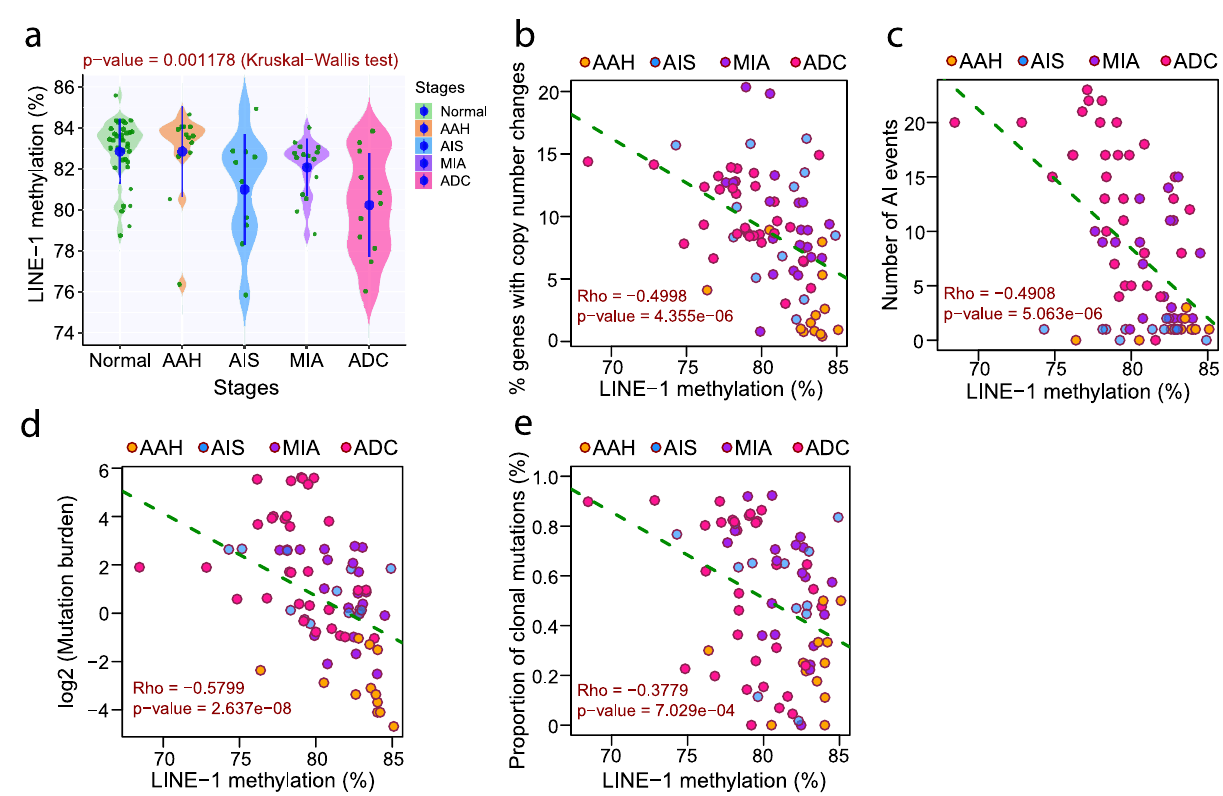
Fig. 6 Correlation of LINE-1 methylation with genomic features in IPNs of different stages. a LINE-1 methylation level in IPNs of different stages. Each green dot represents LINE-1 methylation level in each IPN and the solid blue dots represent the means of LINE-1 methylation level in IPNs of each histologic stage with 95% con fi dence intervals as error bars. The differences among all stages were assessed using the Kruskal – Wallis H test. Correlation between LINE-1 methylation levels and percent of genes with copy number changes ( b ), number of events with allelic imbalance (AI) ( c ), mutation burden (log 2 transformed) ( d ), and proportion of clonal mutations ( e ), assessed by two-tailed Spearman ’ s correlation analysis. Each dot represents each IPN specimen. Source data is provided as a source data fi